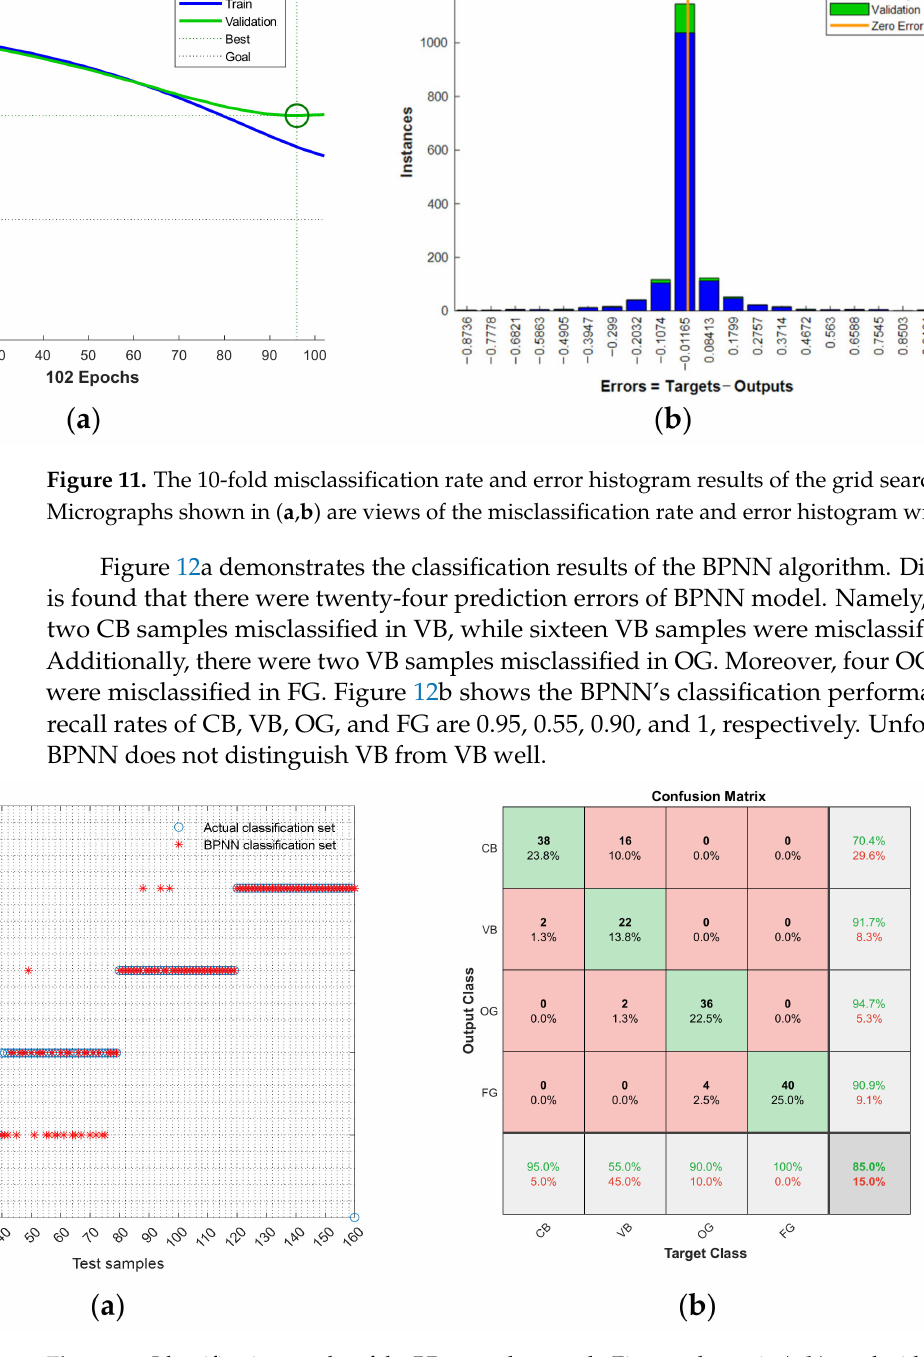
Figure 12. Identification results of the BP neutral network. Figures shown in ( a , b ) are the identification results of BPNN and its confusion